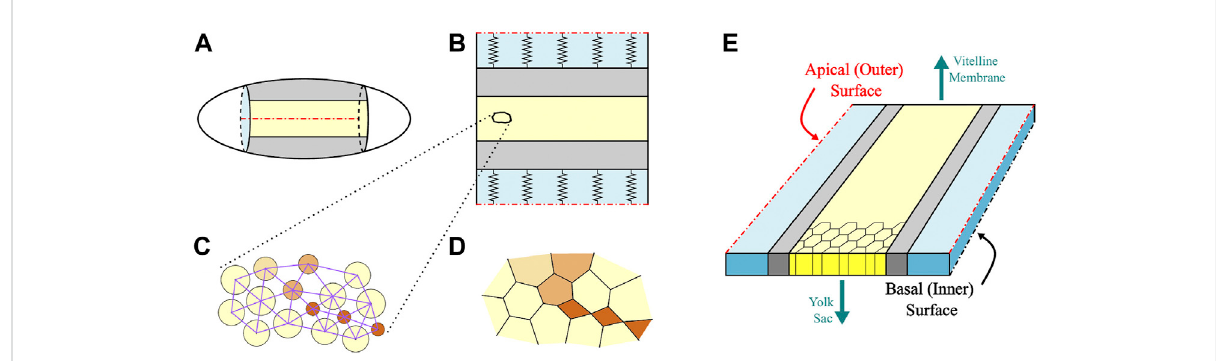
FIGURE 4 SchematicoftheAGF model. (A) Thesimulateddomainofthe Drosophila embryo.The active ventraland thepassivelateralregions aremarked in yellow and gray, respectively. (B) The simulated region is mapped onto a rectangular domain with periodic boundary conditions in the anteroposterior direction. The outer part of the passive region (light blue in the fi gure) is modeled implicitly as an elastic medium represented by springs. (C) The cells are described using force centers interacting via repulsive and attractive forces. The repulsive forces (represented by circles) act between all contact cells. The attractive forces (represented by lines) act only between neighbors and do not switch during the progression of the constriction process. (D) The con fl uent cell layer is obtained from the force center system using the augmented stress-based Voronoi construction. In both (C,D) , the constricted particles are marked in brown; the color intensity represents the degree of constriction. (E) At